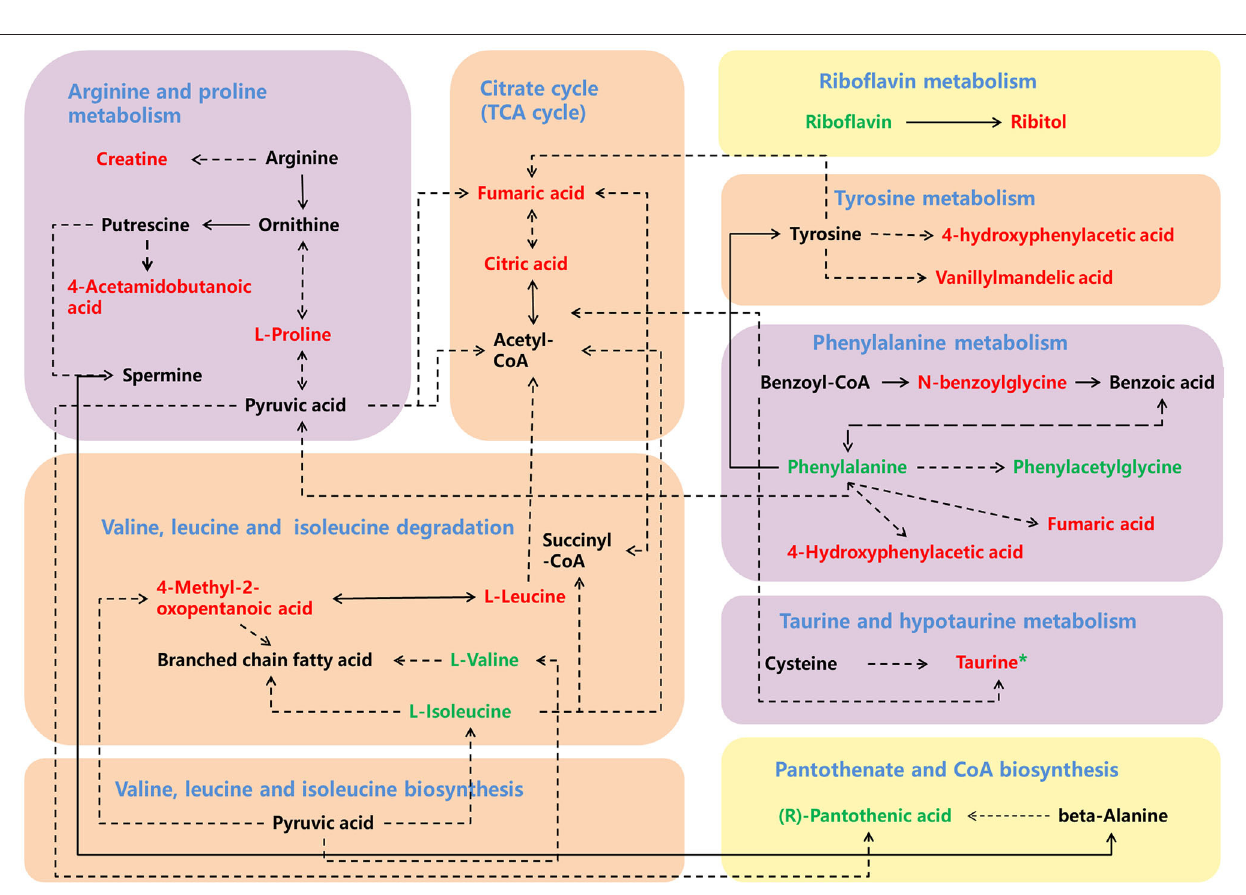
FIGURE 6 | A schema showing the key enriched metabolic pathways implicated in ASD. The increased discriminating metabolites are labeled in red, and decreased discriminating metabolites are labeled in green, while the green * labeled taurine indicates its decreased level in urine. The yellow, orange, and purple backgrounds indicate enriched metabolic pathways in urine, plasma and both urine and plasma